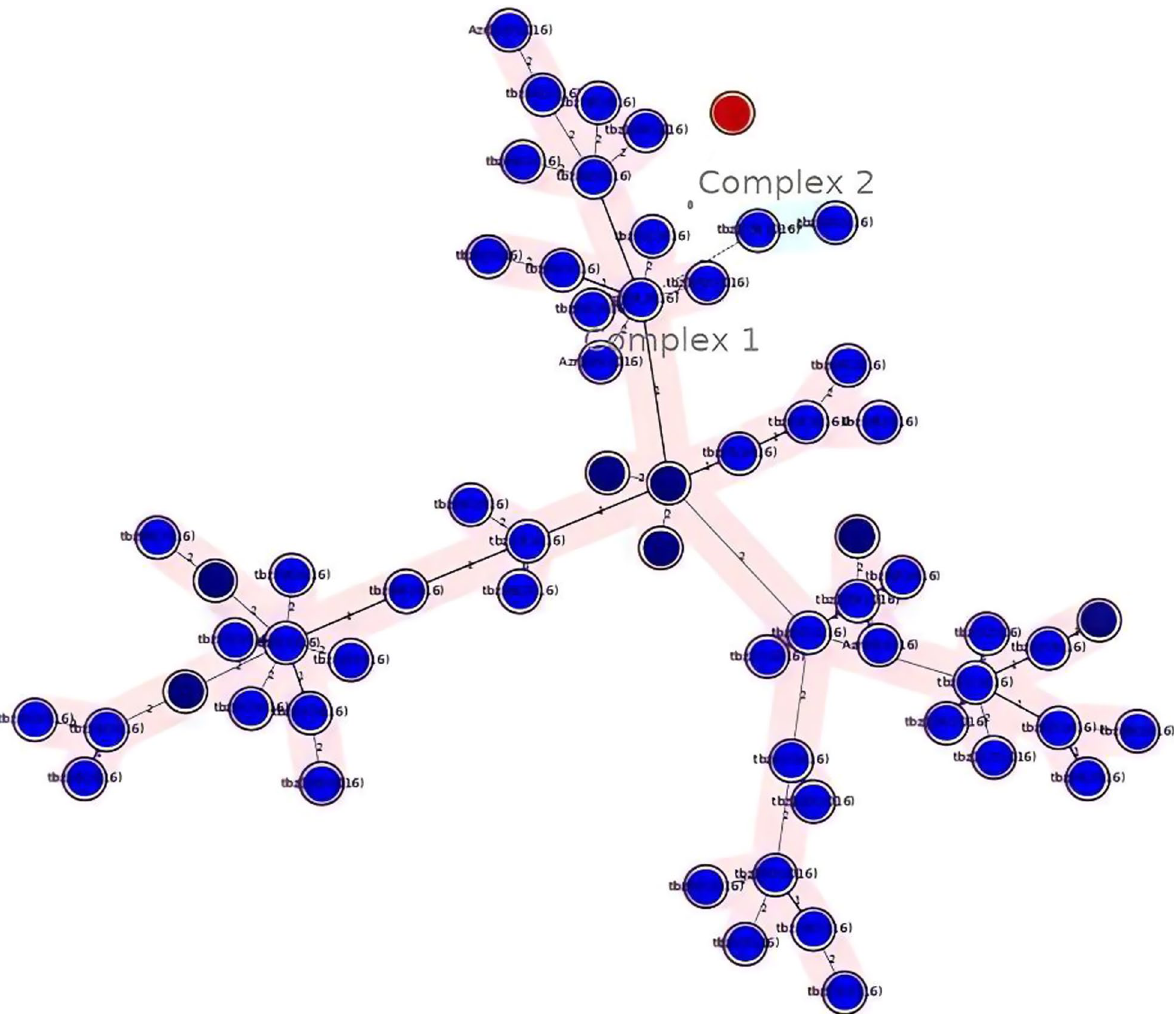
Fig. 2 Relationship of the MIRU-VNTR pattern of non-cluster isolates with other categories. The blue circle indicates the MIRU-VNTR pattern isolates and the dark circles indicate the number of isolates in a cluster. This figure shows how diverse are clusters from each other and they not too close